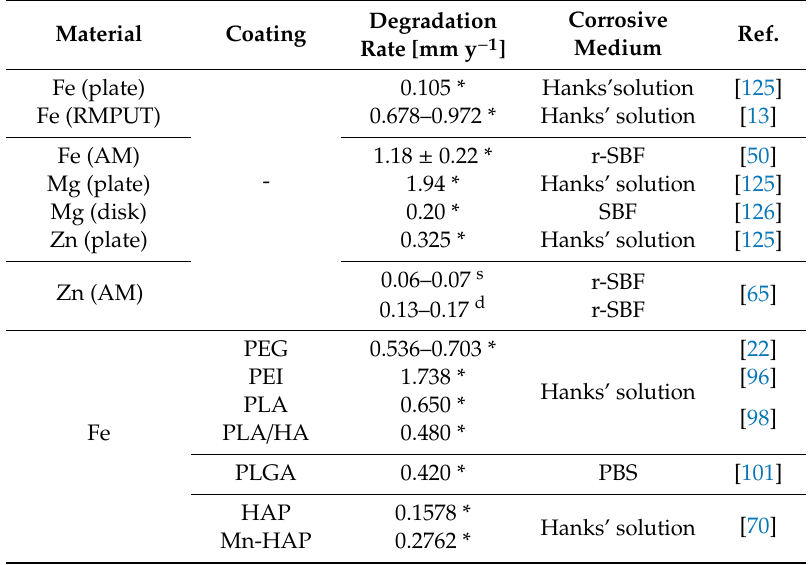
Table 3. Comparison of degradation characteristics of some uncoated vs. coated metallic foams intended to serve as medical